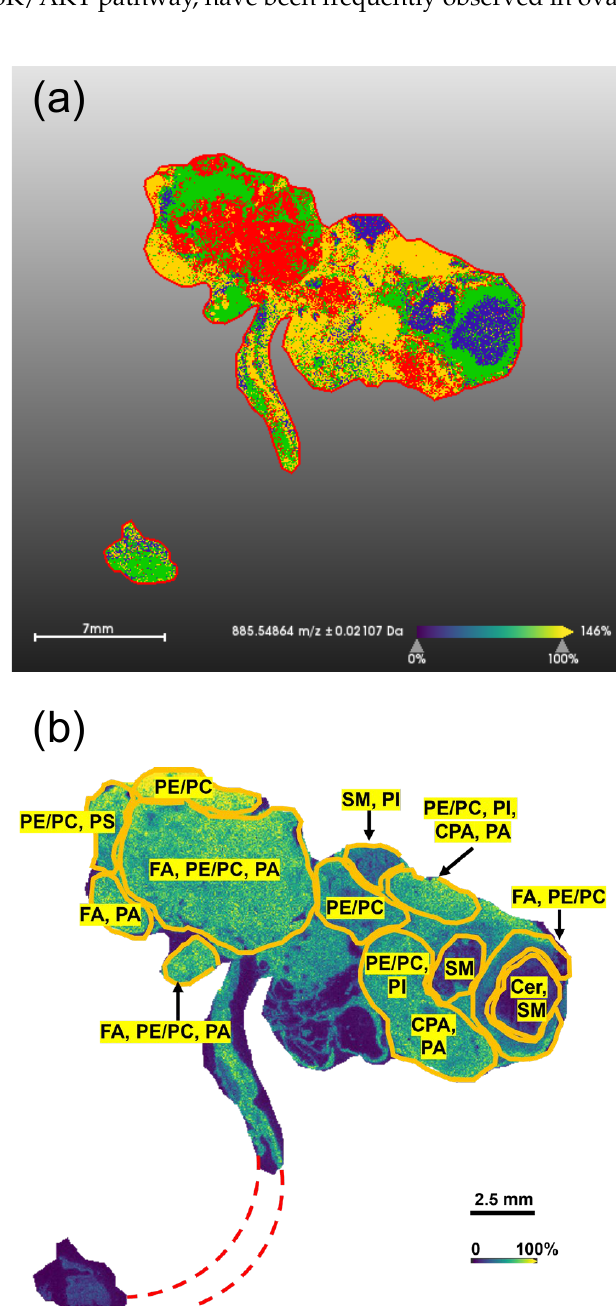
Figure 3. Spatial lipidomics results for the reproductive system of a TKO animal. ( a ) Spatial segmentation of the TKO tissue using a bisecting k-means algorithm, where major sub-regions of the tumor can be identified (labelled in Figure 4). ( b ) Overall spatial distribution of putatively annotated lipid features in the tumor region of the TKO tissue. Circled sub-regions are labeled with certain lipid species that have significant alterations (increased or decreased) compared to control tissues. The red dashed lines indicate the missing uterus due to imperfect tissue sectioning. FA: fatty acids, PE: phosphatidylethanolamines, PC: phosphatidylcholine, PE O-: ether phosphatidylethanolamines, PI: phosphatidylinositols, PS: phosphatidylserines, Cer: ceramides, SM: sphingomyelins, CPA: cyclopropane fatty acids, PA: phosphatidic acids.